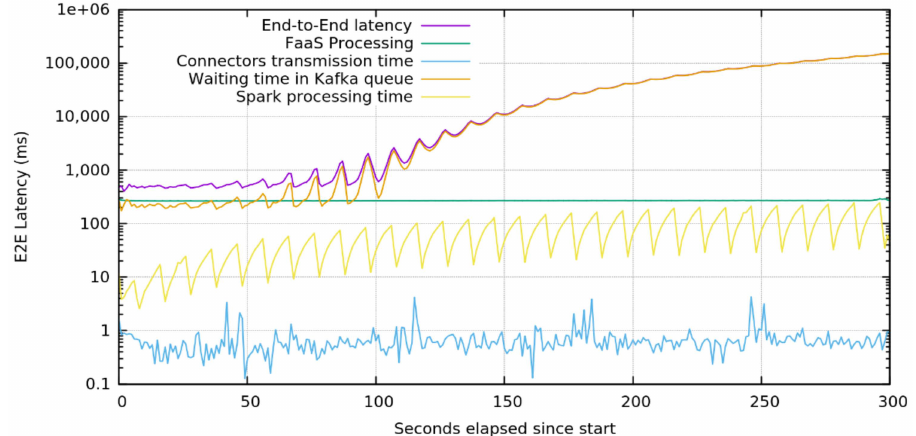
Figure 9. Average latency introduced by each part compared with the tail latency when under an increasing load of messages starting from 0 to 10,000 during a time-lapse of 5